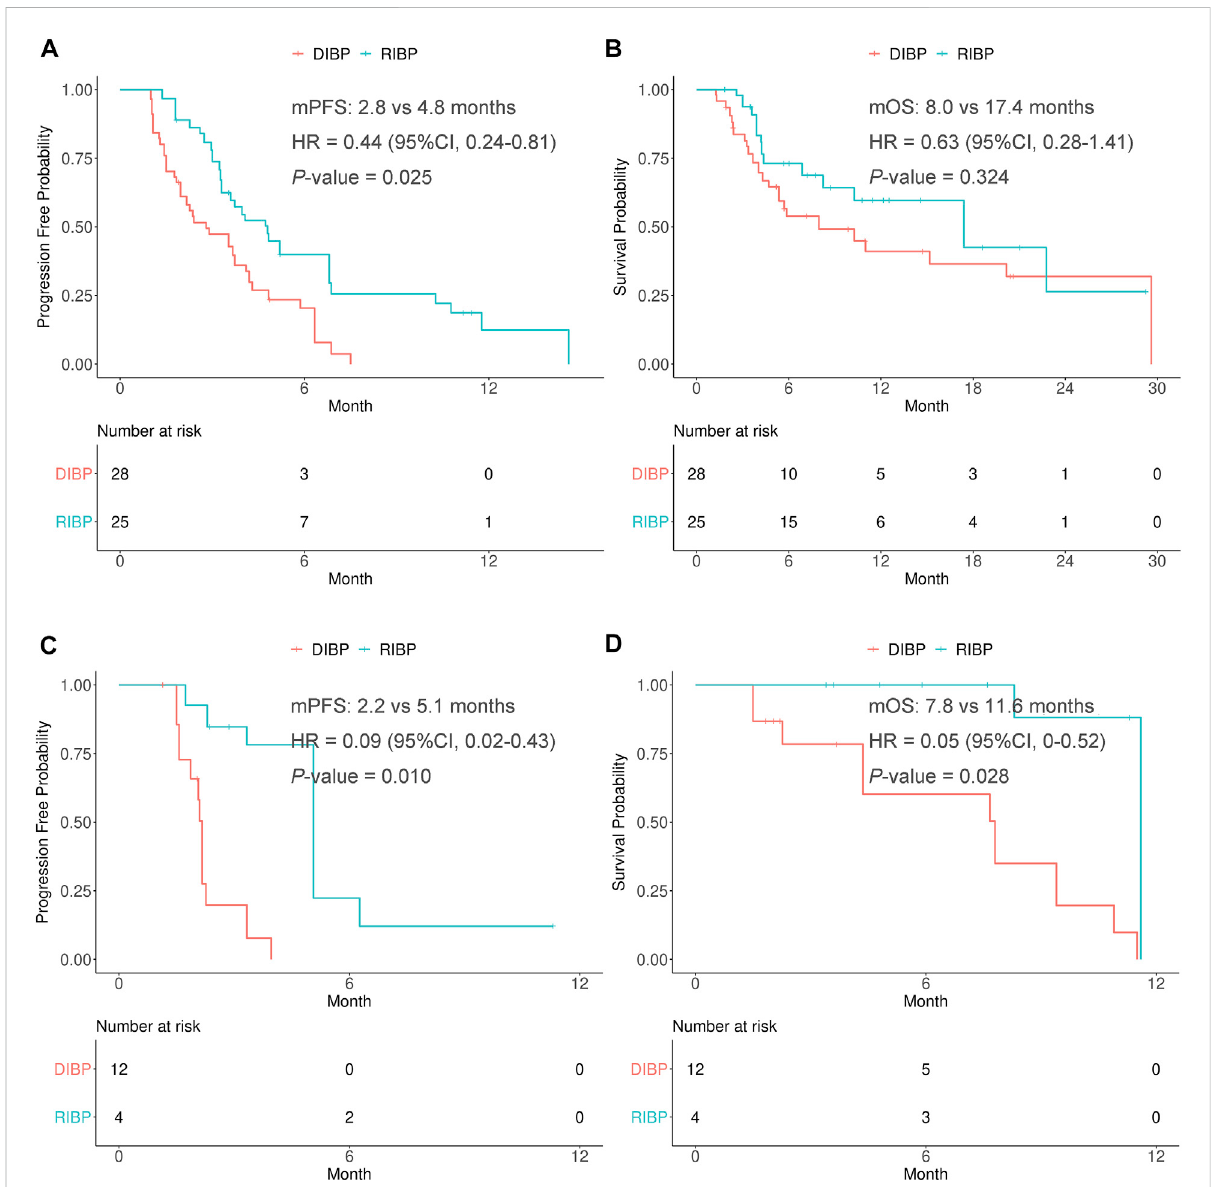
FIGURE 4 Kaplan-Meier curves of PFS (A,C) and OS (B,D) from weighted data in the chemotherapy and anti-angiogenesis therapy subgroups. RIBP, rechallengeofimmunotherapy beyondprogression; DIBP, discontinuation ofimmunotherapy beyondprogression;mPFS,median progression-free survival; mOS, median overall survival; HR, hazard ratio; CI, con fi dence